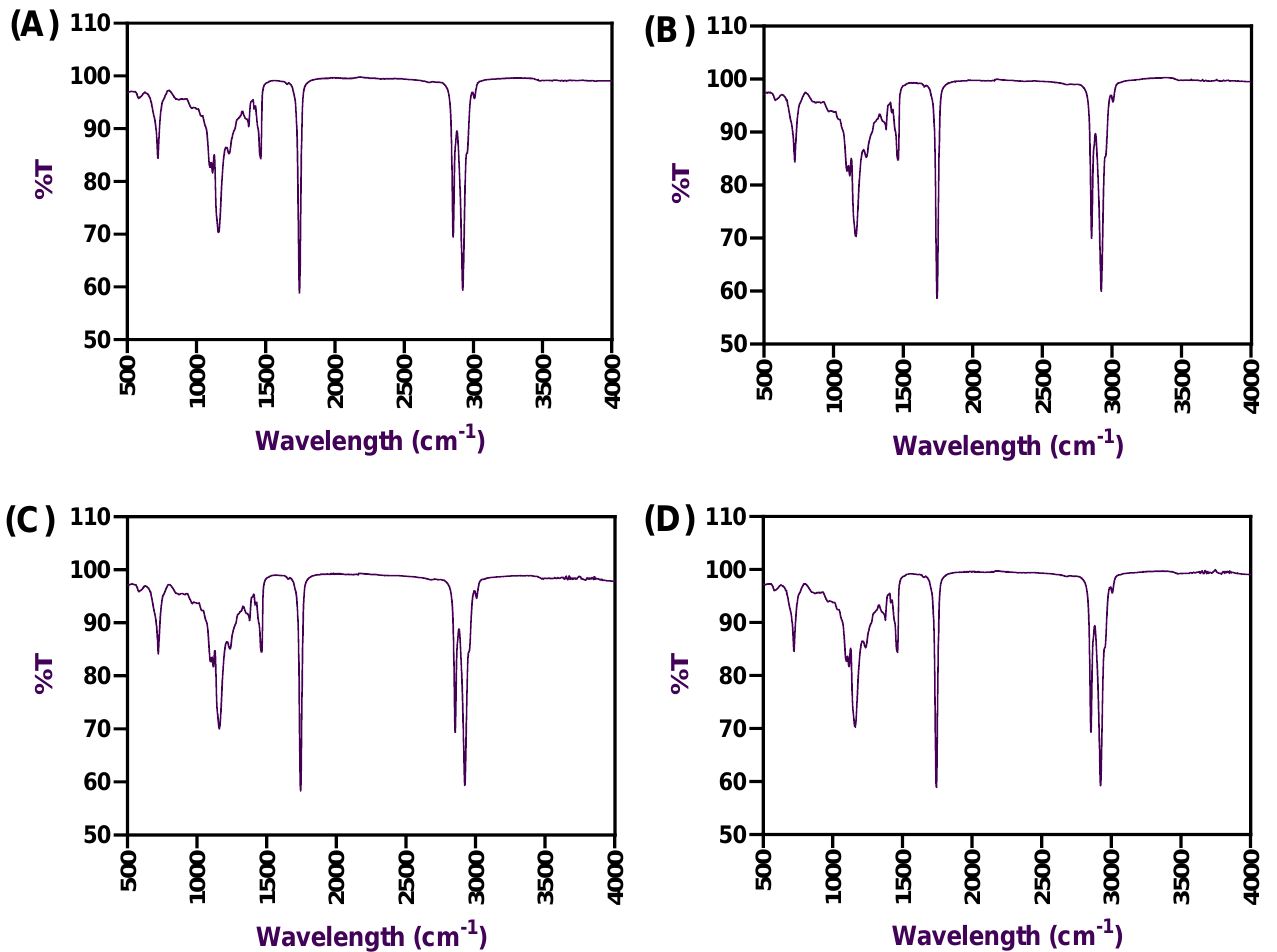
Figure 4. FTIR spectrum of palm oil-based oleogels (OG1 ( A ), OG2 ( B ), OGU1 ( C ), and OGU2 ( D )) prepared with different concentrations of carnauba wax and the ultrasonication process.